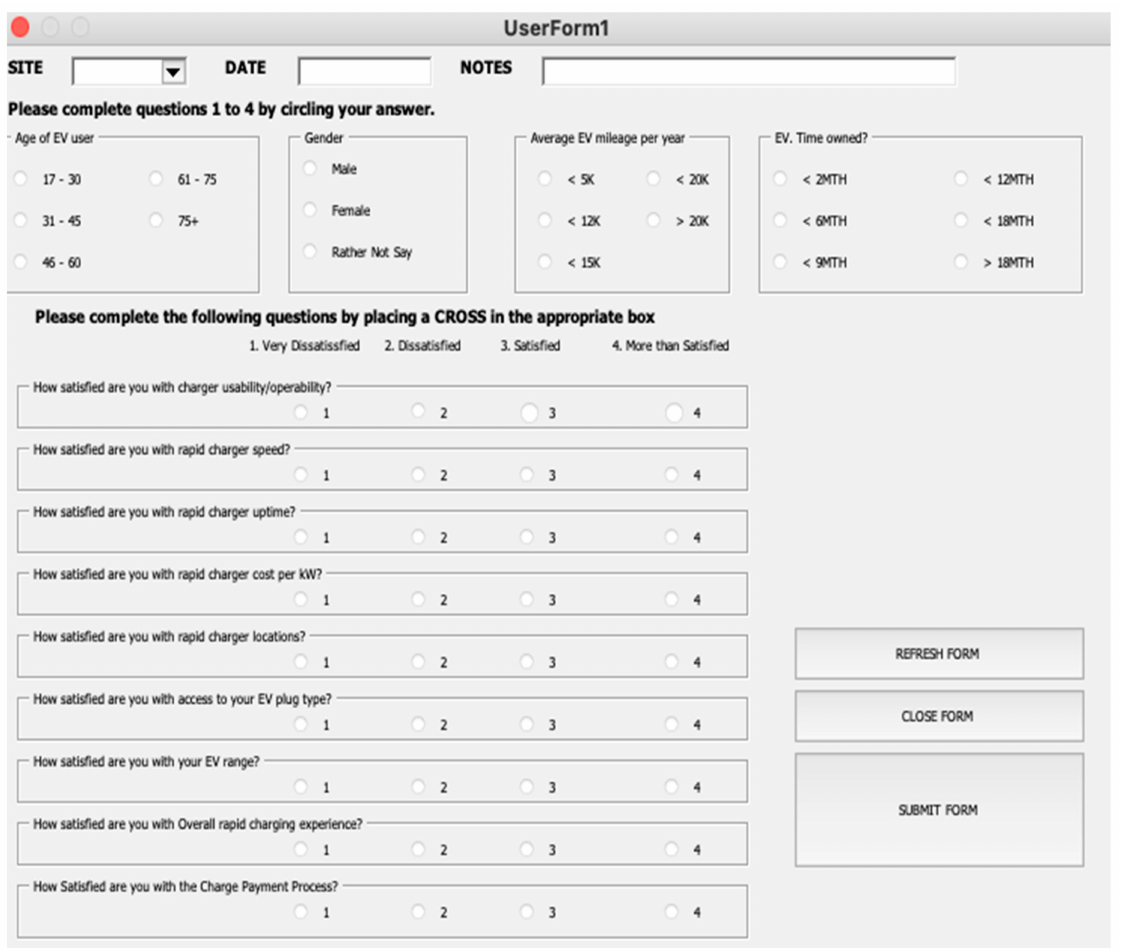
Figure 17. Length of EV ownership per response group.